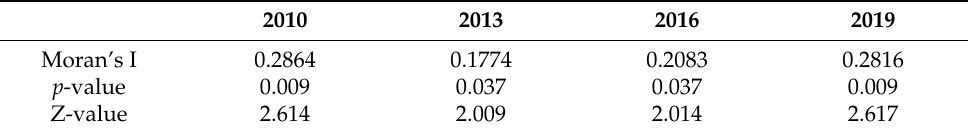
Table 5. Results of the global spatial autocorrelation analysis in Shanghai.